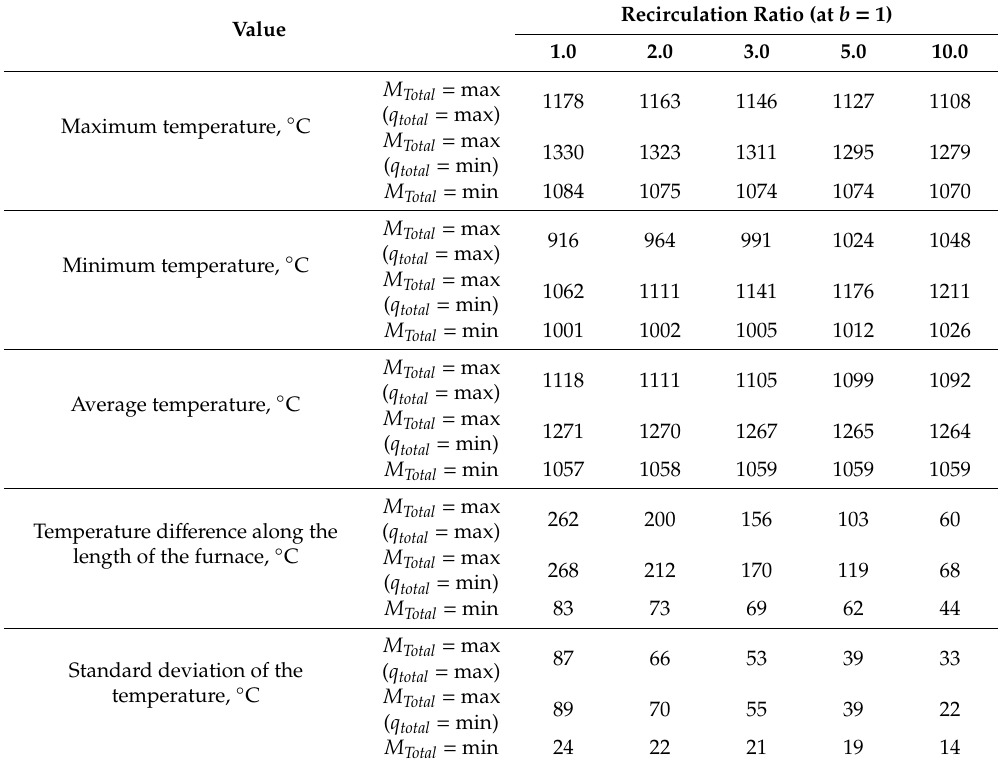
Table 8. The results of calculating the uniformity of the temperature field during reverse movement of furnace gases for di ff erent rates of their